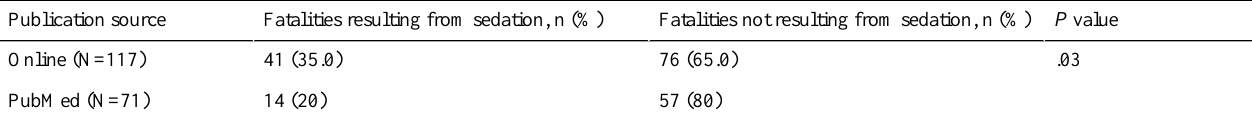
Table 9. Comparison of fatalities in dental facilities as a result of sedation in online and PubMed publications.